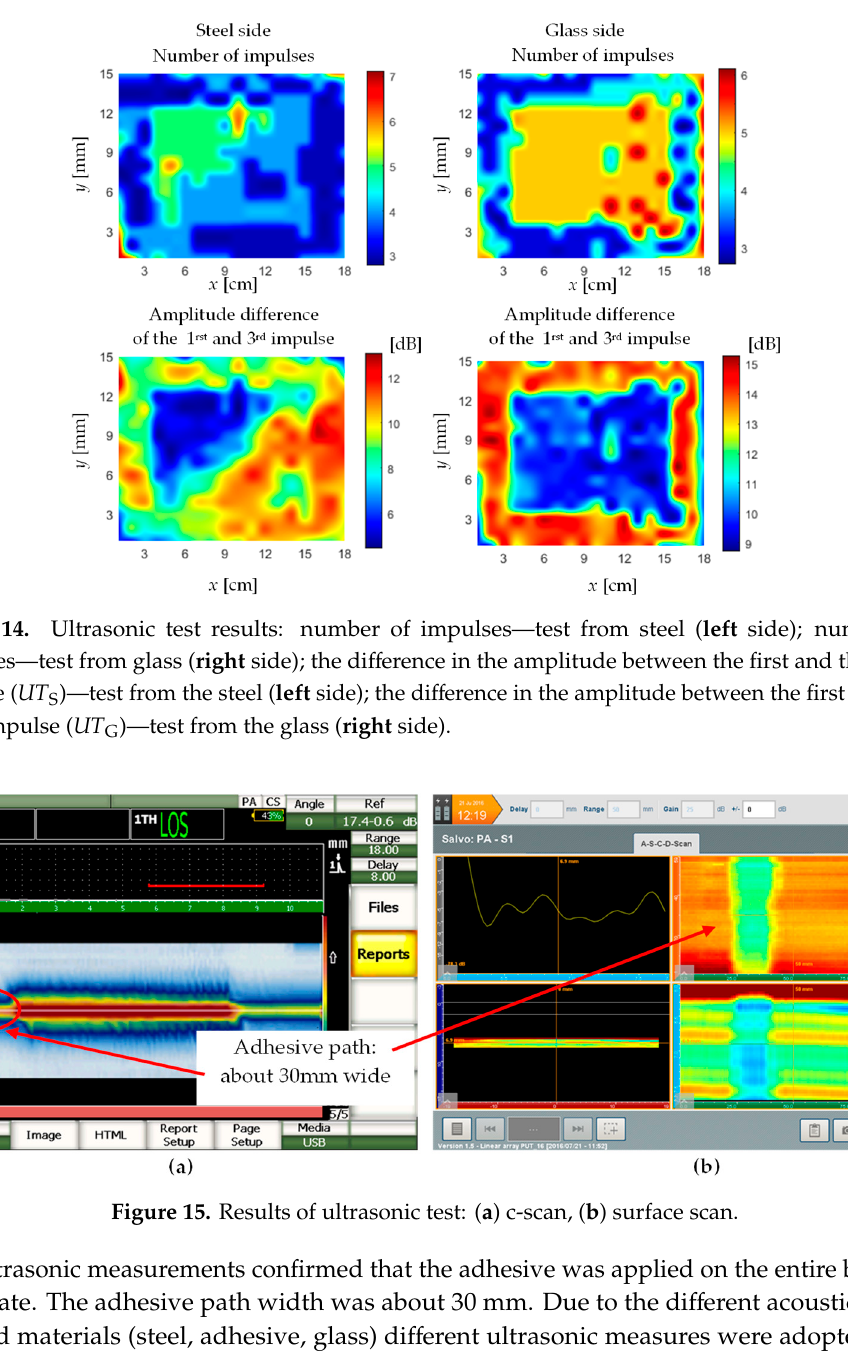
Figure 15. Results of ultrasonic test: ( a ) c-scan, ( b ) surface scan.